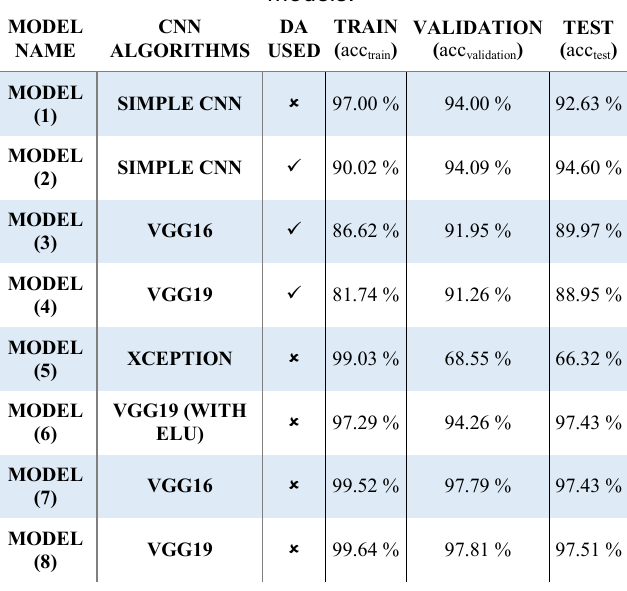
Table 2. Comparative Analysis of different CNN